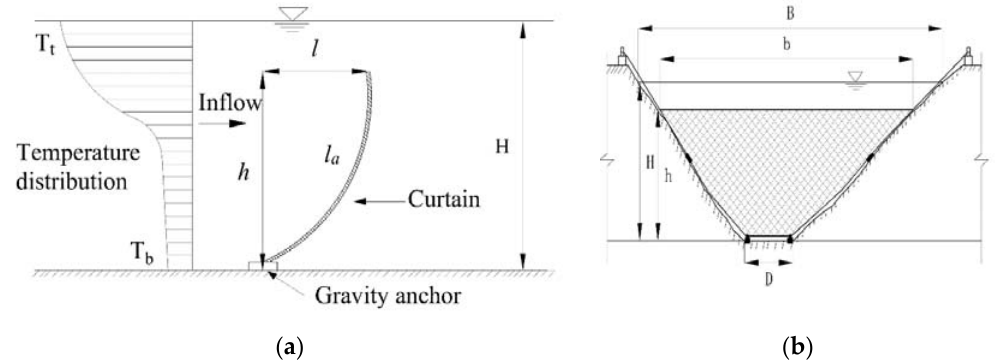
Figure 3. Geometry of the TCC: ( a ) downstream direction; ( b ) cross ‐ section.